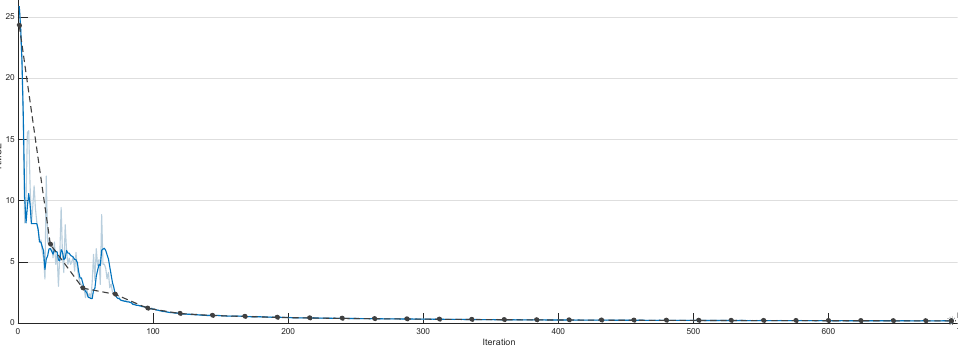
Figure 8. Neural Network training process